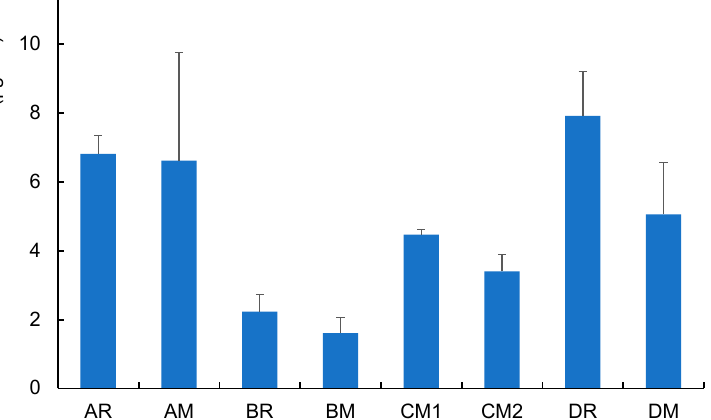
Figure 3. Analytical results on the total emission amount of ammonia (gas + particle forms) from each heated tobacco product (error bars shows standard deviations of triplicate measurements).